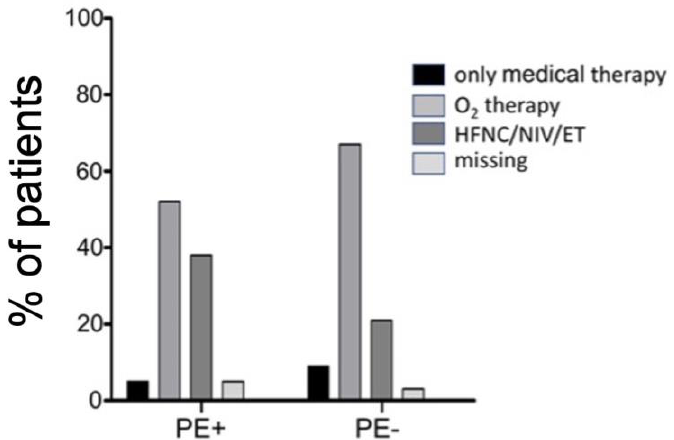
Figure 3. Level of care (HFNC: high-flow nasal cannula; CPAP: continuous positive airway pressure; NIV: non-invasive ventilation; ET: endotracheal intubation) for PE + and PE − patients. p < 0.001 by χ 2 test.